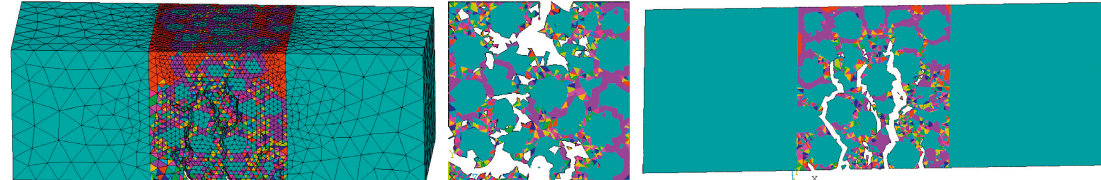
Figure 9: The damage element diagram of the bending